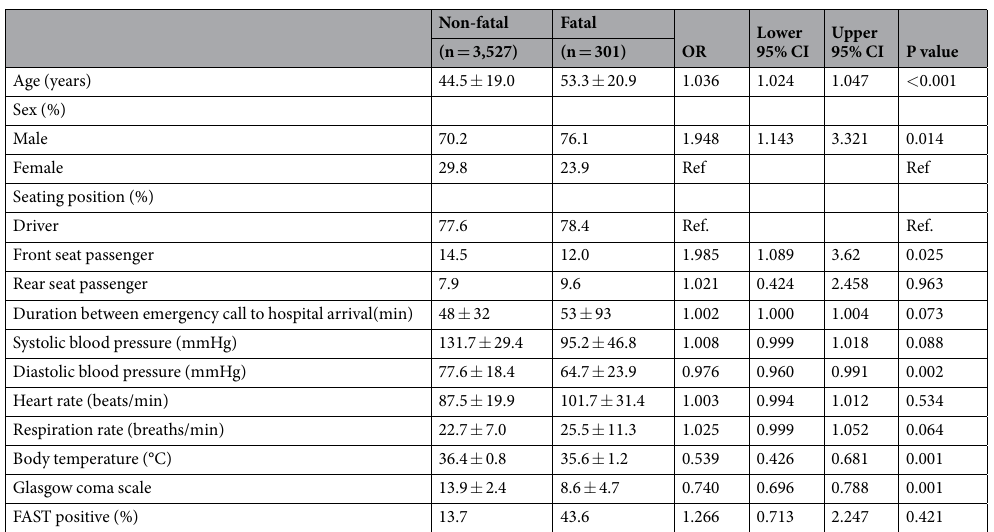
Table 3. Patient characteristics and vital signs at the time of hospital arrival of patients who survived (non- fatal group) versus patients who died (fatal group) during Period A (2004–2008). OR: odds ratio, 95% CI: 95% confidence interval, FAST: focused assessment with sonography for